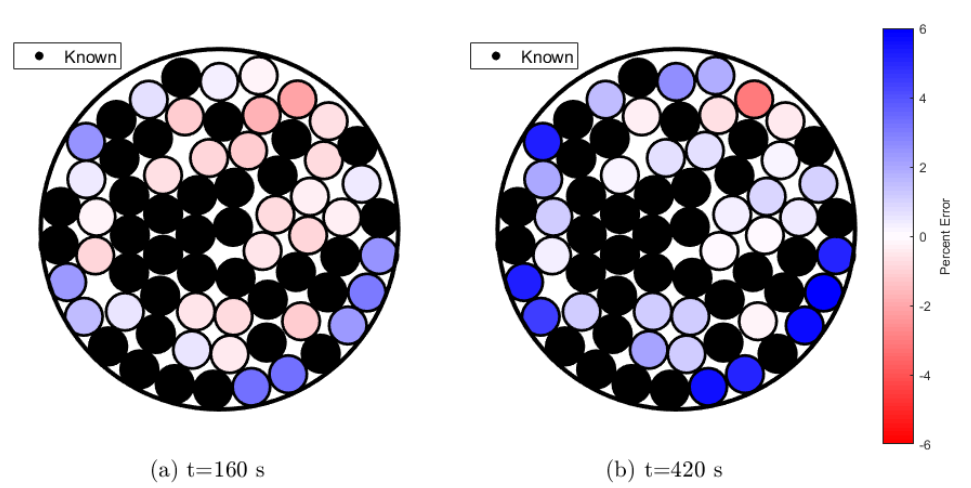
Figure 10. Map of rod assembly showing normalized error after 160 s ( a ) and 420 s ( b ) of